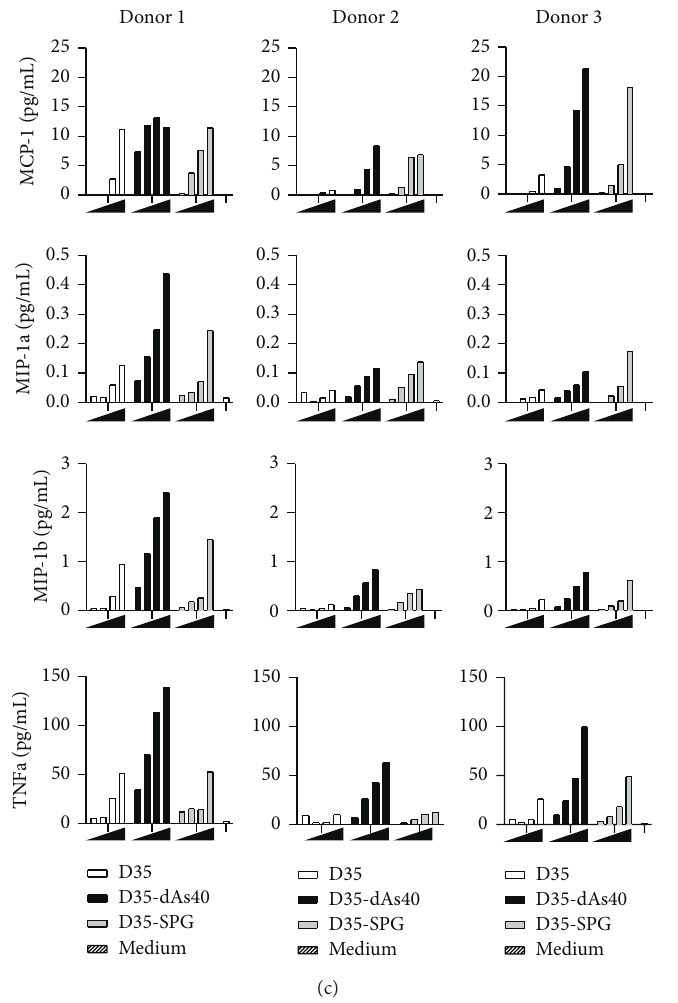
Figure 13: Cytokine profiles of D-type CpG ODNs in human PBMCs. PBMCs from three Japanese adult volunteers were stimulated with D35, D35-dAs40, D35-SPG, or medium. Each ODN was serially diluted (0.74, 2.2, 6.6, or 20 𝜇 g/mL). After 24 hours, the cytokine concentrations in the supernatants were determined with Milliplex cytokine assay